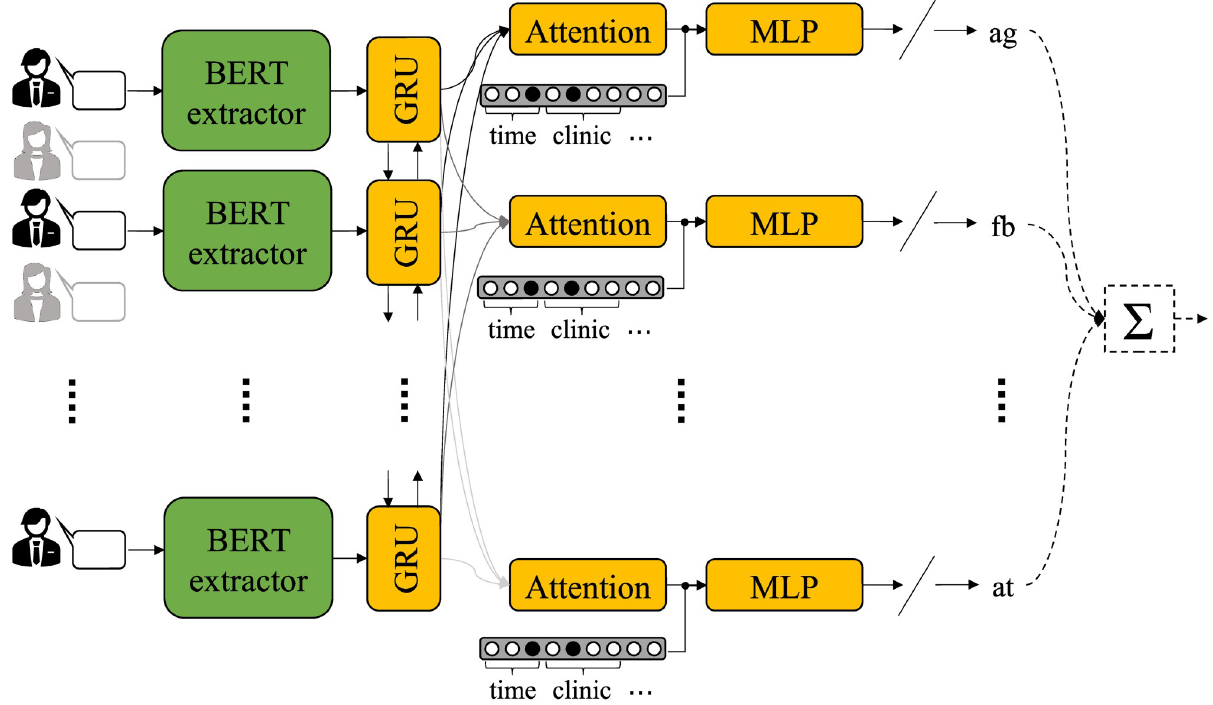
Fig 3. Proposed architecture for total CTRS score classification following a multi-task approach modeling each CTRS code. Here, only the utterances attributed to one of the interlocutors (i.e., therapist) are used.